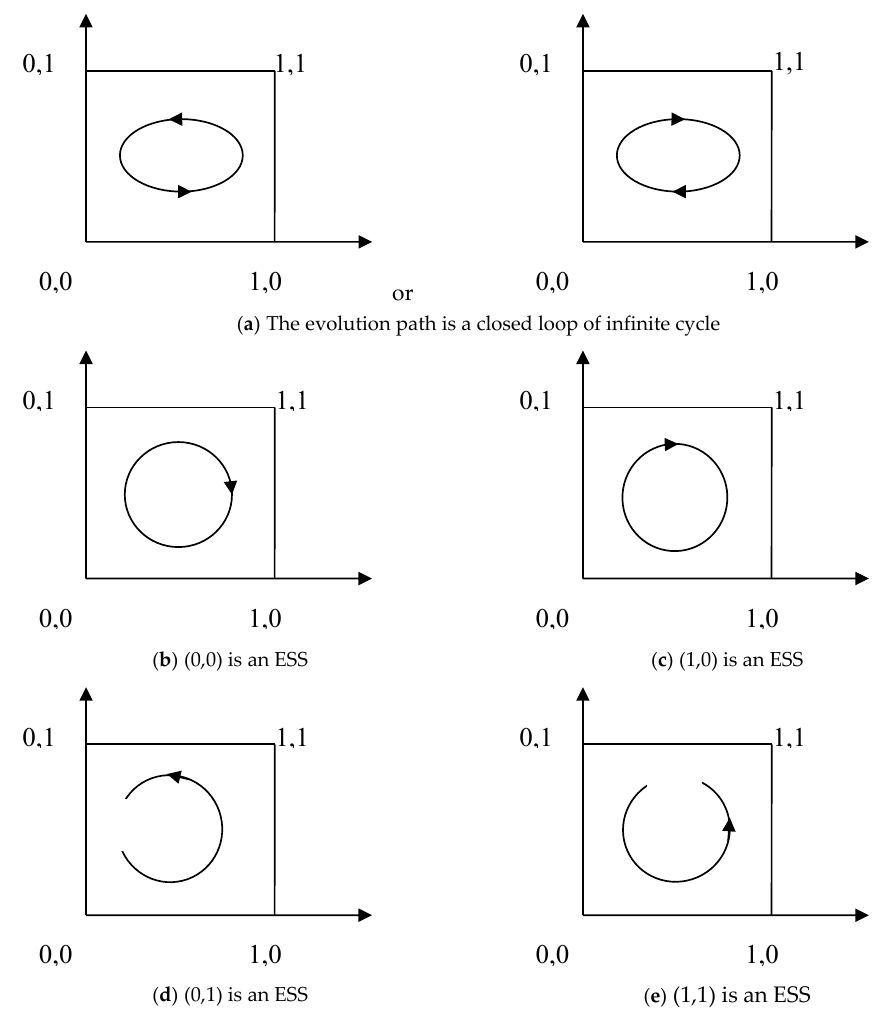
Figure 1. The evolution path of game strategy. ( a ) The evolution path is a closed loop of infinite cycle; ( b ) (0,0) is an ESS; ( c ) (1,0) is an ESS; ( d ) (0,1) is an ESS; ( e ) (1,1) is an ESS.